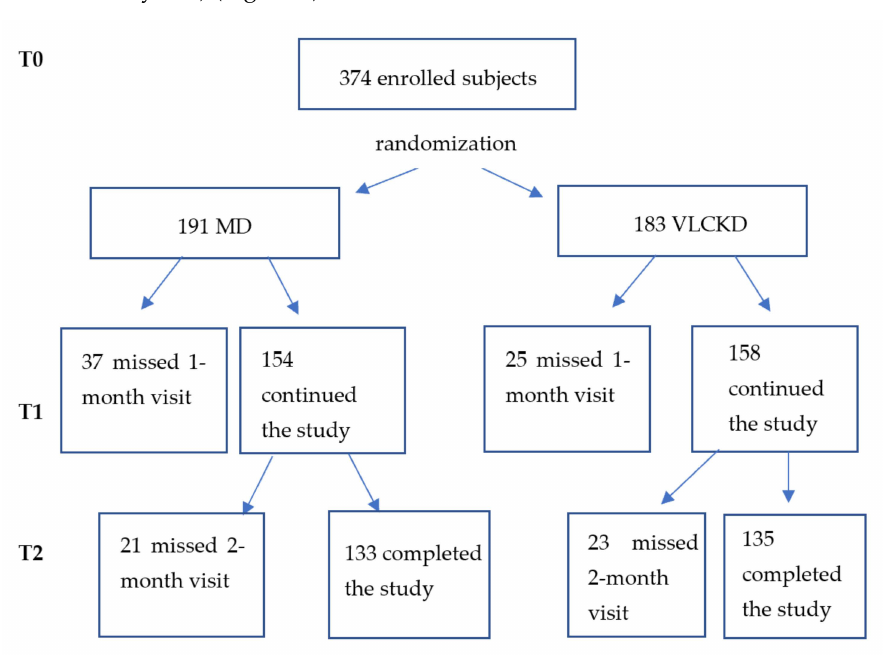
Figure 2. Flow—chart of the enrollment